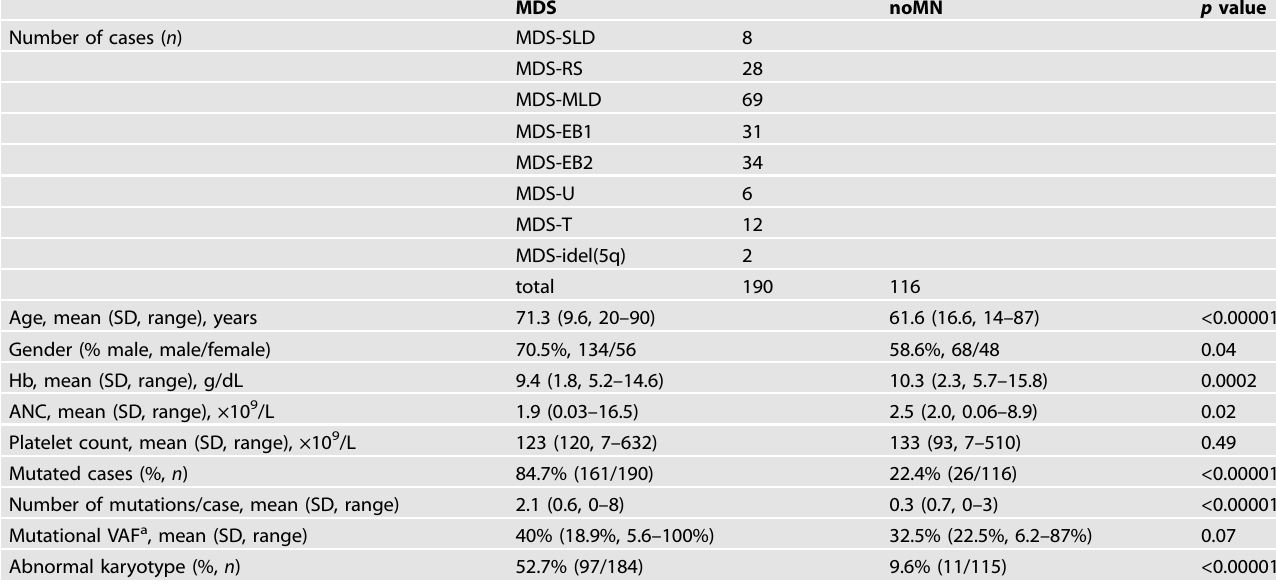
Table 1. Demographic, clinical, and genetic features of 190 MDS and 116 noMN